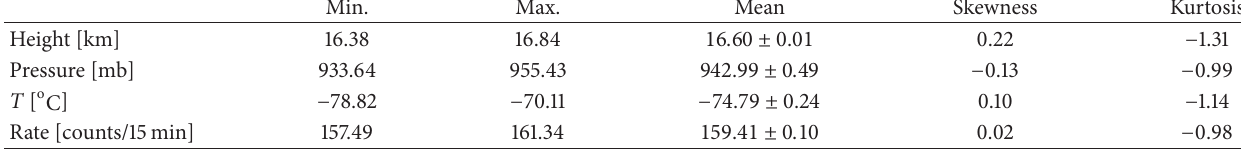
Table 1: Summary of the mean values of the parameters for the considered period.